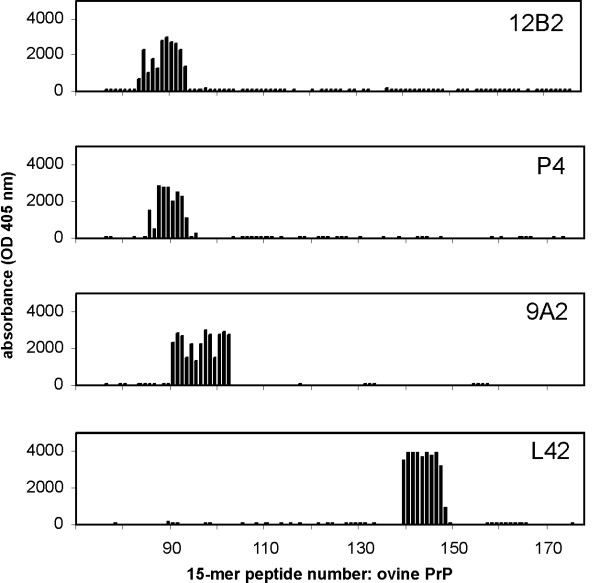
Mapping of antigenic sites in the ovine PrP sequence for 4 monoclonal antibodies by Pepscan analysis. For each antibody indicated, results of analyses are presented for peptides 76–175. Antigenic peptides for the respective antibodies 12B2, P4, 9A2, and L42 are: 83–93, 85–93, 90–102 and 139–148. See Table 1 for deduced core of the epitopes.